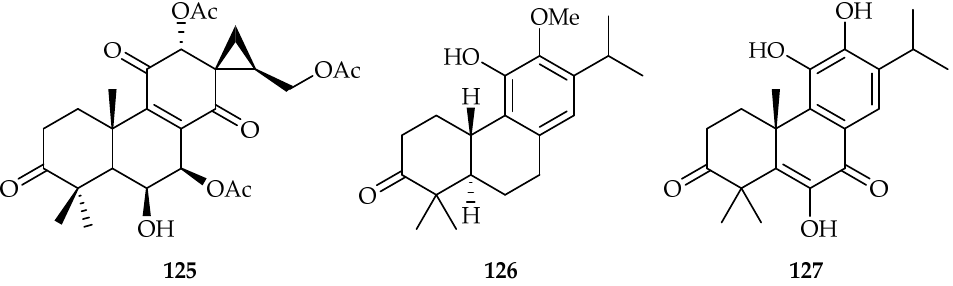
Figure 51. Structures of euphelionolides F 123 [76] e L 124 [76]. Three new abietane-type diterpenoids possessing a spiro-cyclopropane moiety, named spiroscutelones A–C, were isolated from the leaves of Plectranthus scutellarioides (Lamiaceae), which is distributed in China, India, Indonesia, the Philippines, and Australia. Spiros- cutelone B 125 exhibited the most potent cytotoxicity against the MCF-7 cell line, with an IC 50 value of 17.9 µ M, while it had low cytotoxicity against the normal cell line (WI-38) [77] (Figure 52).